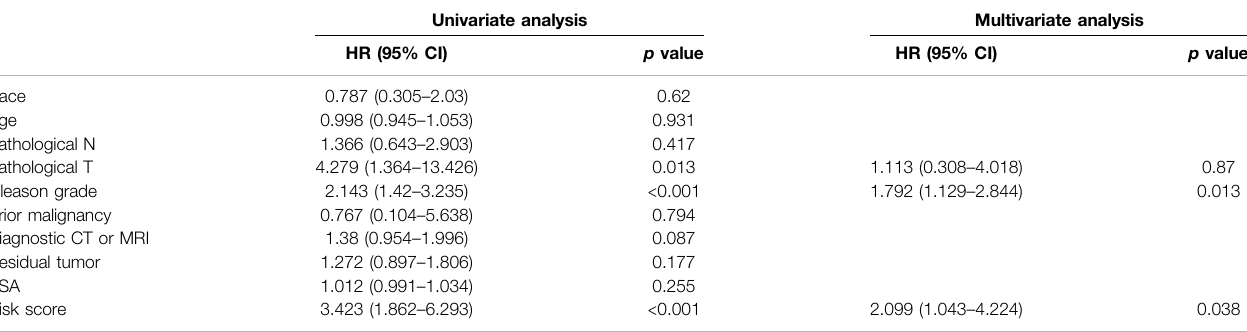
TABLE 4 | Results of univariate and multivariate Cox regression.